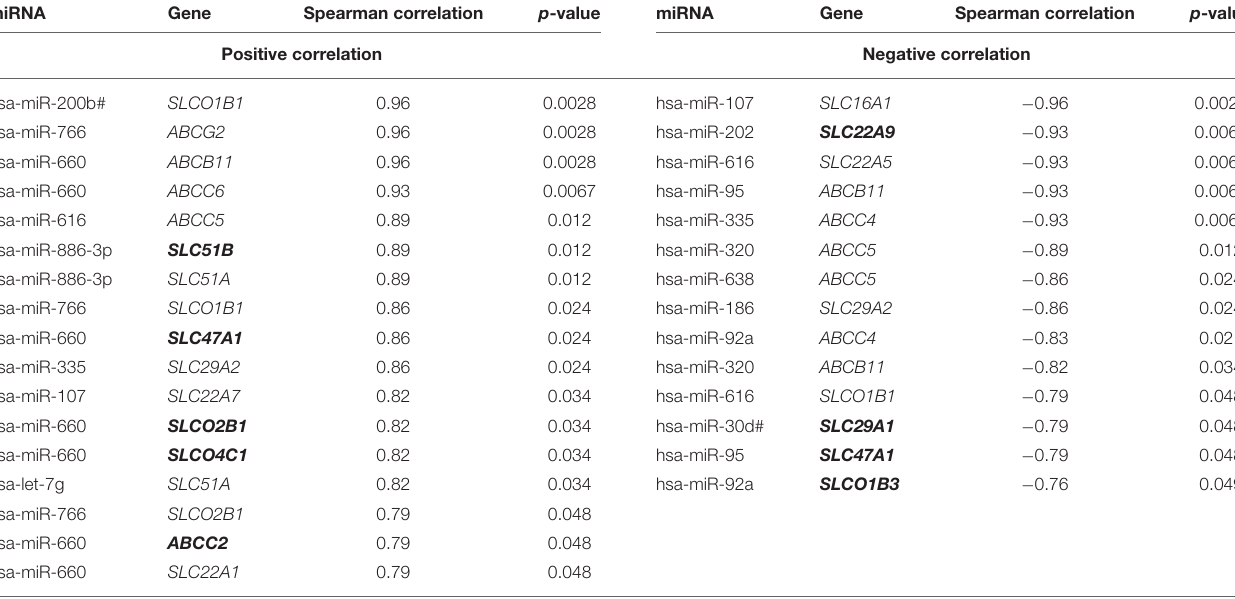
TABLE 3 | All clinically relevant drug transporters correlated with miRNA induced by rifampin with a p < 0.05. miRNA Gene Spearman correlation p -value miRNA